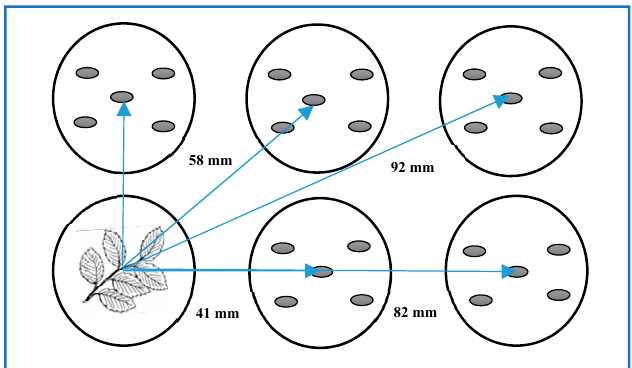
Figure 2. The layout of the dish pack (DP) method. The six-well plastic dish was used to test the volatile allelopathy of plants. A total of 200 mg of dry plant samples were used in the corner well (source well), and five lettuce seeds were used for rest of the wells, to design the volatile allelochemicals assessment.